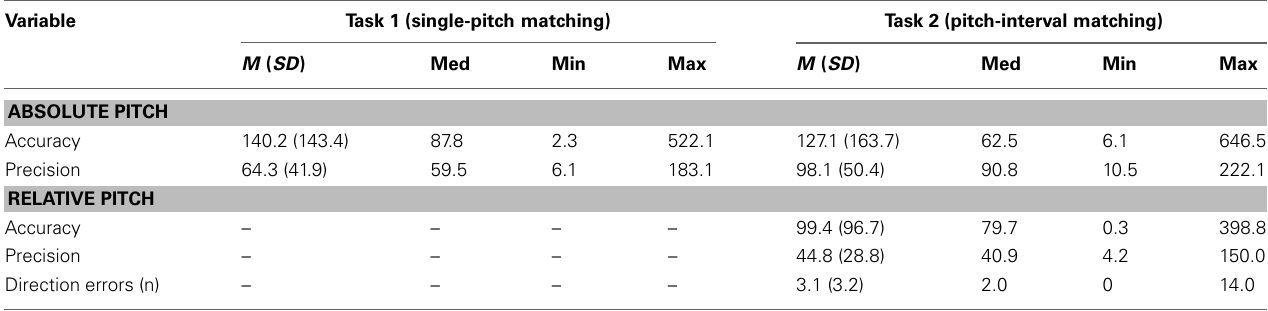
Table 1 | Singing proficiency of 50 occasional singers in Tasks 1 and 2 of the SPB.